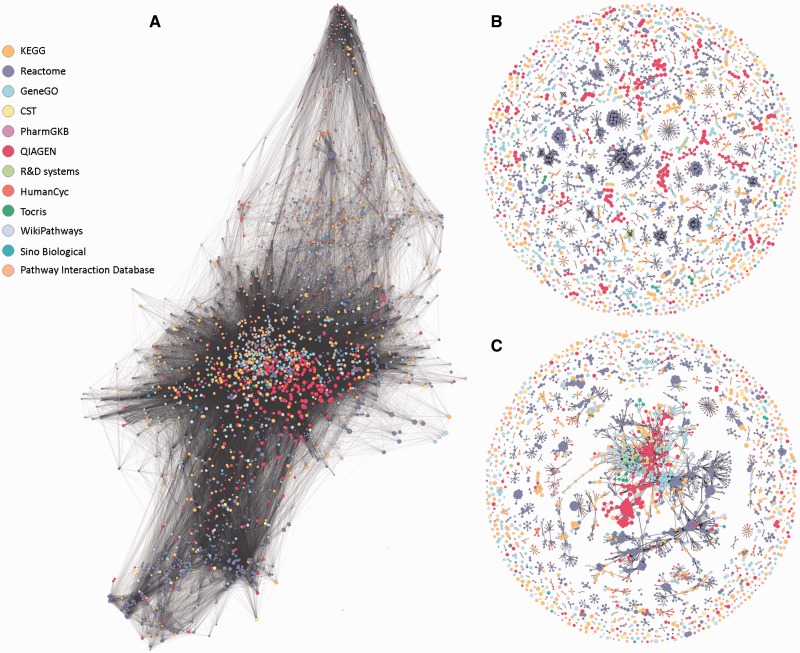
Network representations of the 3215 analyzed pathways. Nodes represent pathways and edges represent Jaccard similarity coefficients (J) using different methods. Network visualizations were performed using Gephi (30). Colors correspond to pathway sources. (A) No clustering. All edges with J ≥ 0.05 are shown. All but 20 pathways form one large connected component with an average degree of 134. (B) SuperPaths. Each is a connected component obtain by the main clustering algorithm, with thresholds T1 (best edges) of J ≥ 0.3 and T2 of J ≥ 0.7. There are 544 singletons and 529 multi-pathway clusters; the size of the largest cluster is 70. (C) Pure hierarchical clustering, with thresholds T2 of J ≥ 0.3. There are 544 singletons and 288 multimembered clusters; the size of the largest cluster is 1046 pathways.